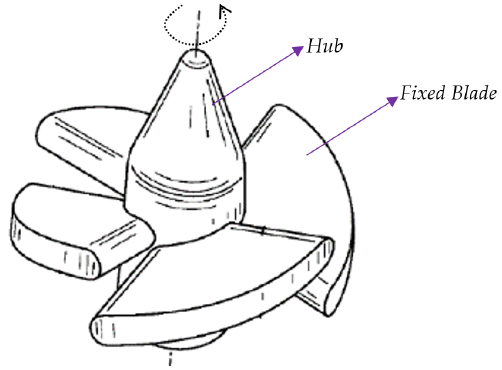
Figure 17. Swirl vanes proposed by Chlappetta et al. [73].